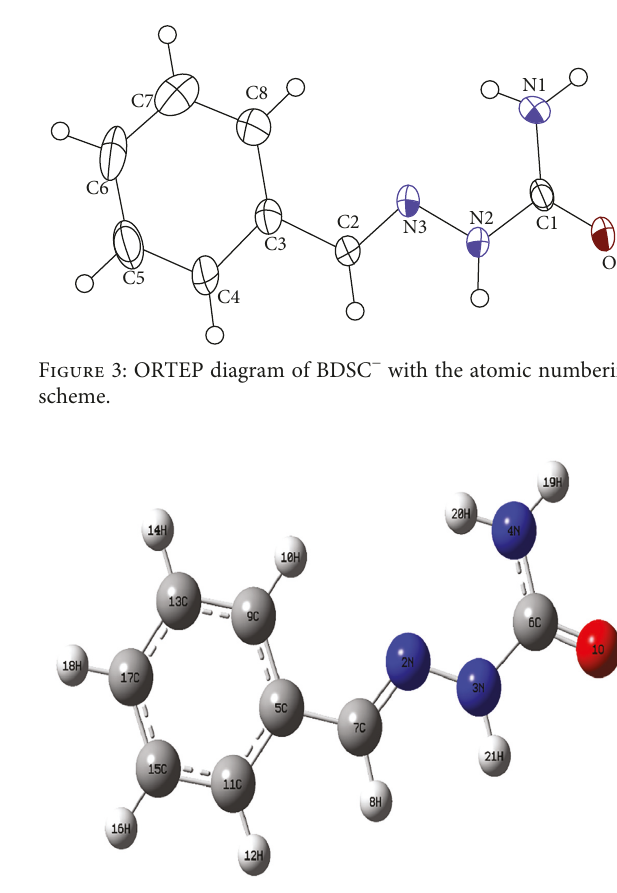
Figure 4: Optimised molecular structure of